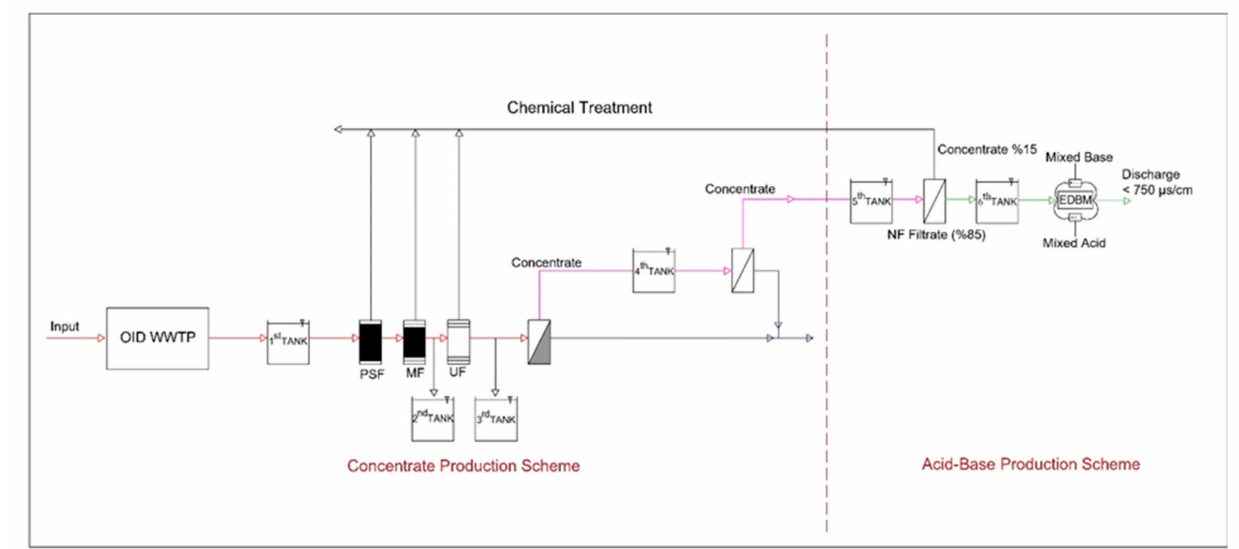
Figure 1. Flow chart of the pilot plant where the concentrate from the RO system and the acid-base are